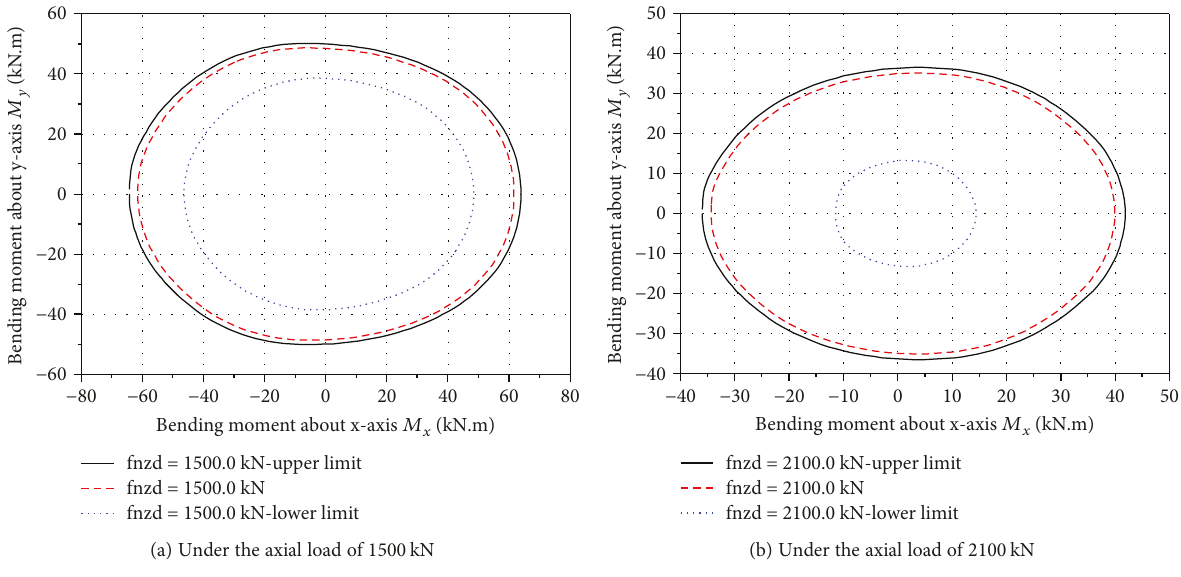
− M Figure 4: M x y interaction curves of the prede